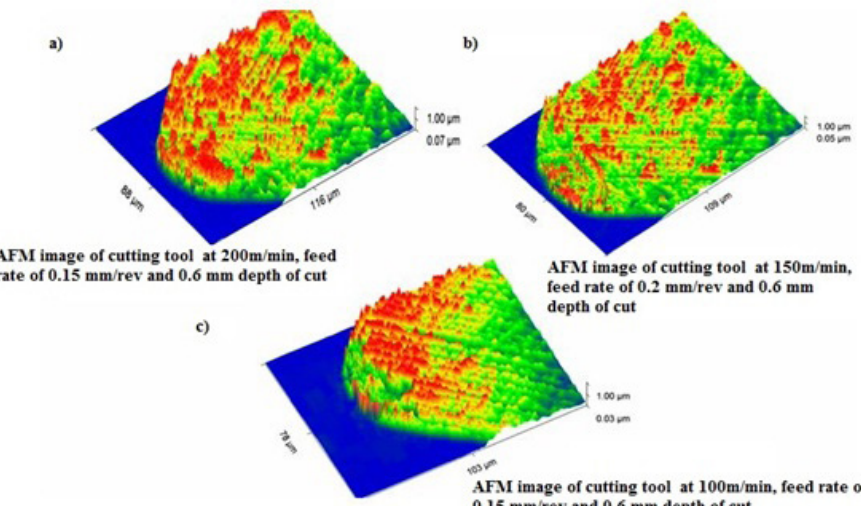
Figure 10. Tool surface morphology at different cutting speed.